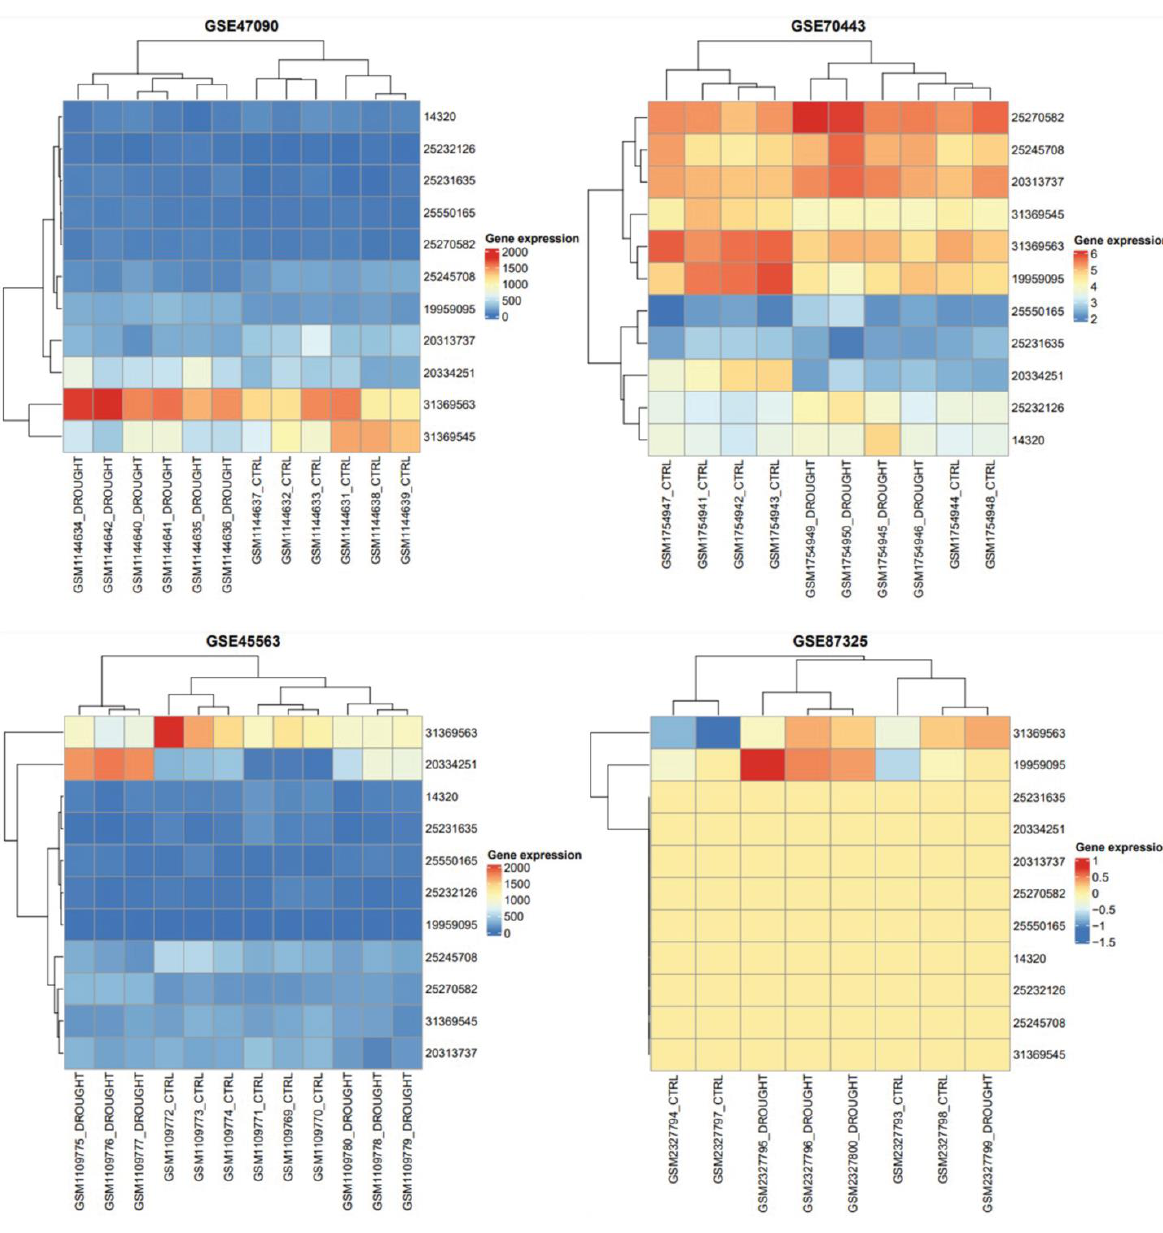
Figure 4 . Heatmap and hierarchical clustering for gene expression matrices under well-watered and drought-stress conditions in 11 SDGs are shown as heatmaps. Color ranges are set between blue and red in order to visualize low to high gene expression, respectively. Clustering analysis of GSE47090, GSE70443, GSE45563 and GSE87325 showed two main horizontal groups of drought and controlled samples. Whereas, vertical scale is used to show all SDGs common in all gene expression datasets. Drought gene with GI accession 25550165 tends to be underexpressed in all experiments. Similarly, 313690563 gene in drought conditions had a trend towards overexpression in all gene expression datasets.